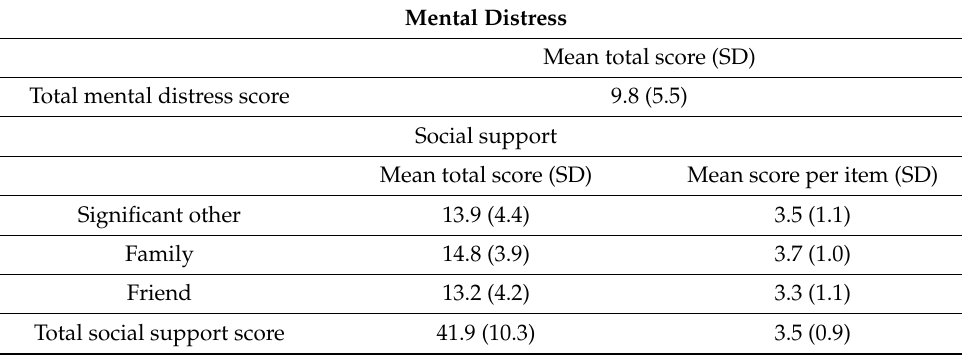
Table 2. Mental distress and social support scores of the